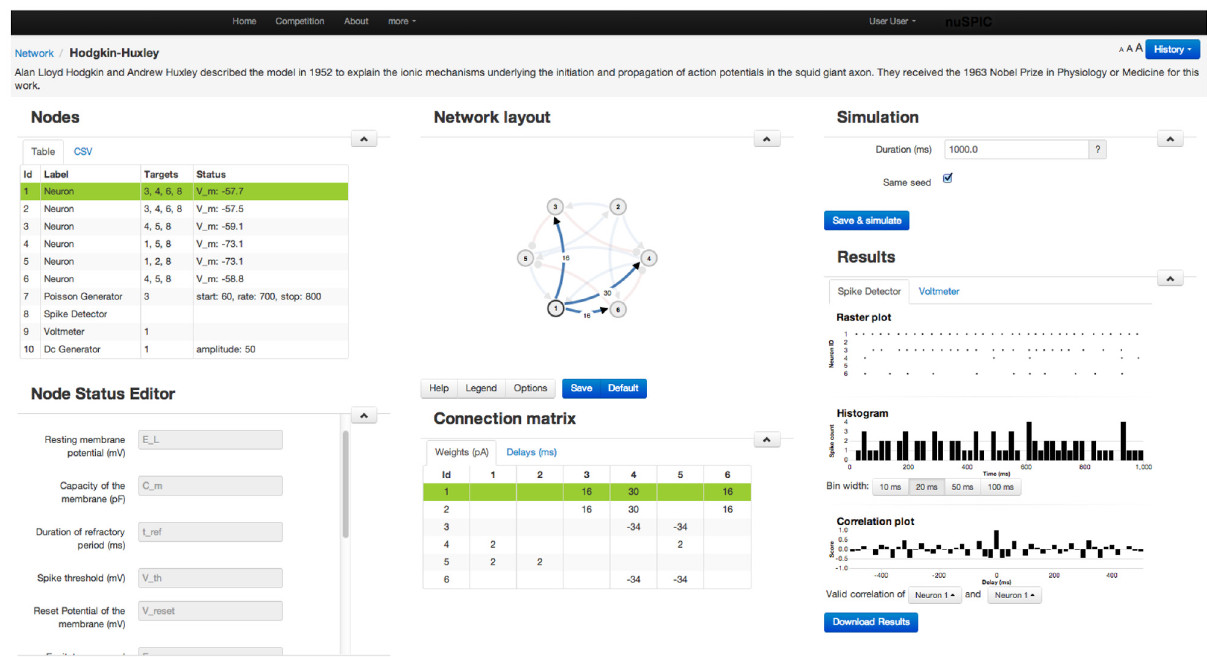
of the network in the form of the peri-stimulus time histogram, cross-correlogram of the spiking activity and sub-threshold membrane potential (cf. Figure 3 ). For further analysis the network output can be